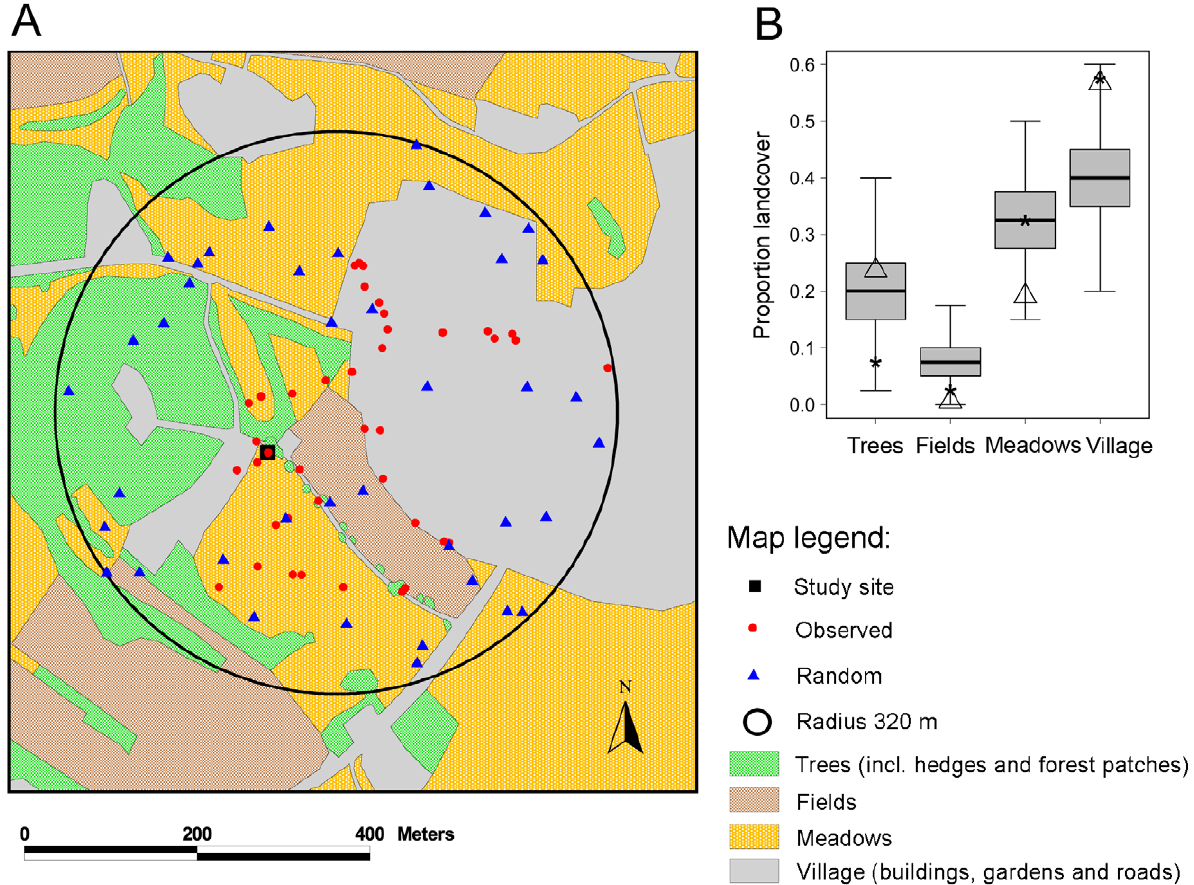
Figure 4. Habitat use of one bumblebee individual ( Bombushortorum , bee 1, Table 1). ( a ) Map of major landcover types with observed bumblebee locations (red points, n =40) and one realization of random points (blue triangles, n =40) within a radius of 320 m around the mean center of the 40 observation points. A total of one thousand realizations of random points (each with n =40) were used to simulate random habitat use around the mean center of the 40 observation points. ( b ) Proportional use of four landcover types in comparison to simulated random habitat use (1000 simulations). Boxplots indicate simulated random habitat useas measured by intersecting landcover types withone thousandrealizations of 40 random points. Asterisks denote the proportional use of landcover types as observed from radio-tracked bumblebee locations (red points in ( a )). Triangles show the proportional use of landcover types when locations are weighted by the time the bee spent at them. Statistical results of testing differences between observed and simulated random habitat use are provided in Table